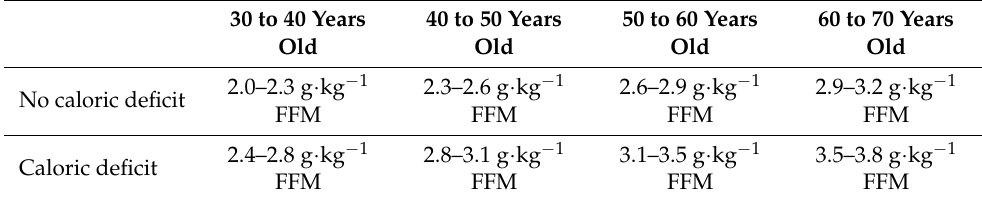
Table 2. Protein recommendations based on age and fat-free